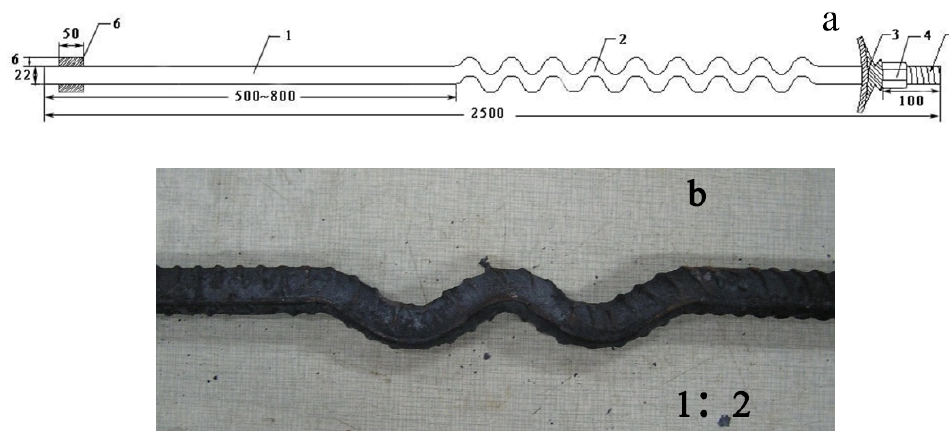
Figure 12. The wave-type bolt’s construction diagram. 1—Prolonged anchor section, 2—Sine-wave structure section, 3— Pallet, 4—Fastening nut, 5—Threaded section, 6—Stirring wing. Note: ( a ) The wave-type bolt; ( b ) Sine-wave structure section.